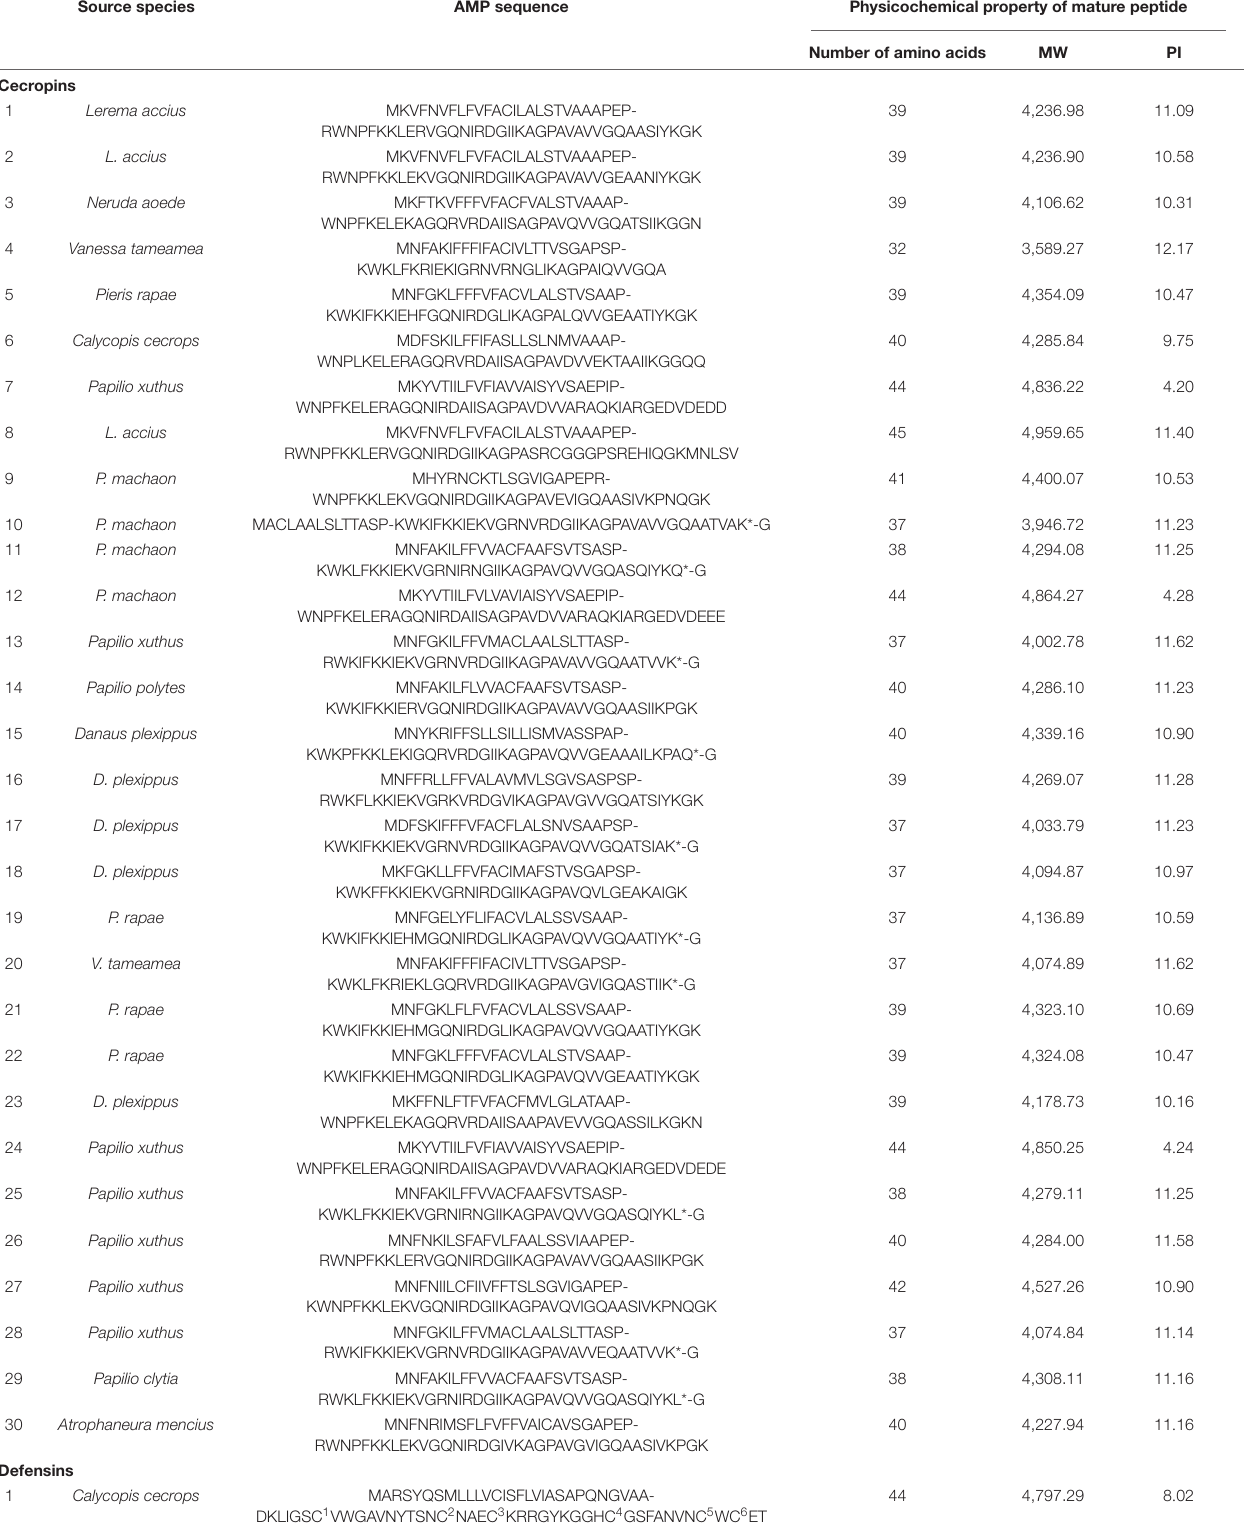
TABLE 1 | List of antimicrobial peptides of butterflies. Source